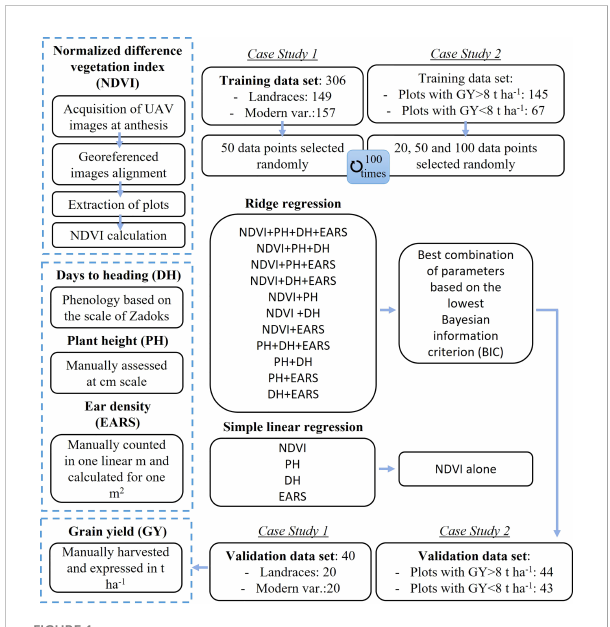
FIGURE 1 Flowchart of data acquisition and model elaboration. DH, days to heading; PH, plant height; NDVI, normalized difference vegetation index; EARS, ear density; UAV, unmanned aerial